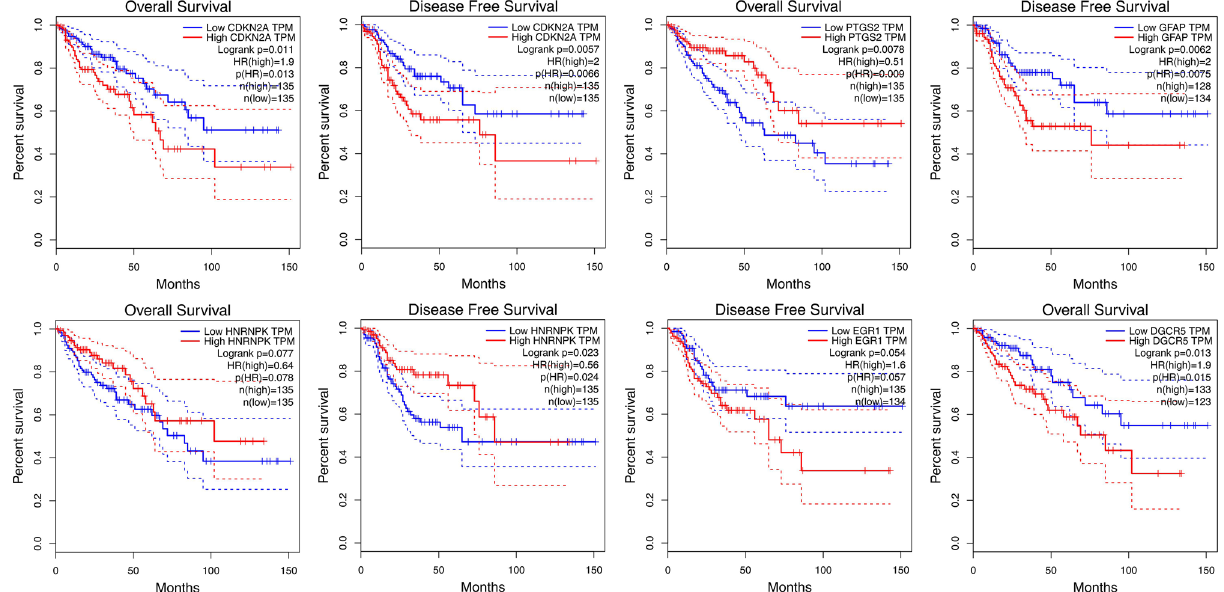
Figure 7. The survival analysis of the hub genes, TFs, and lncRNAs in the prognosis of colorectal cancer. The Kaplan–Meier plot indicates the prognostic ability of hub genes, TFs, and lncRNAs signatures in CRC.